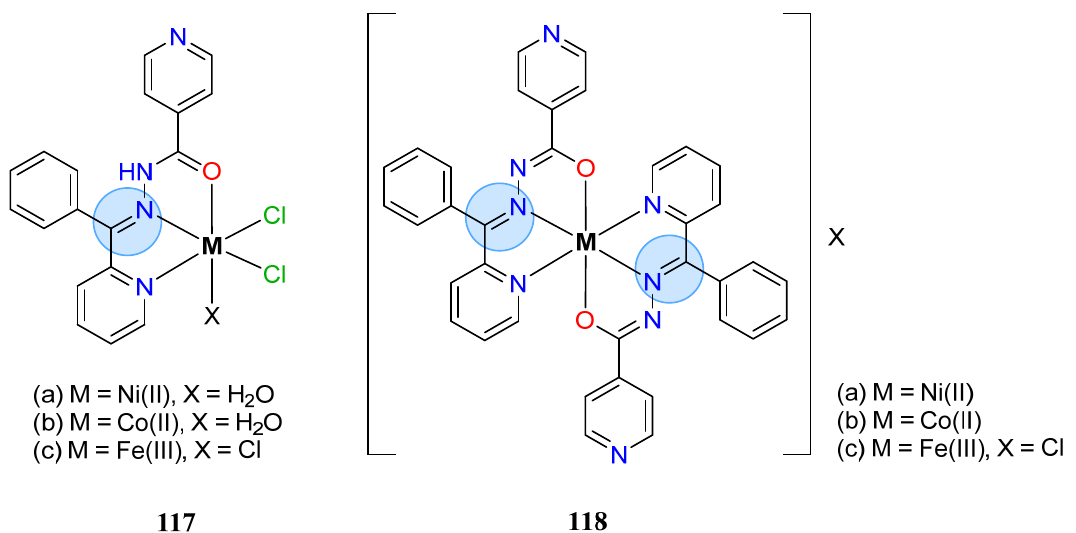
Figure 61. Metal complexes with NNO pincer ‐ like ligand named (E) ‐ N ′‐ (phenyl(pyridin ‐ 2 ‐ yl)meth ‐ Figure ylene)isonicotinohydrazide studied for their antibacterial activity.